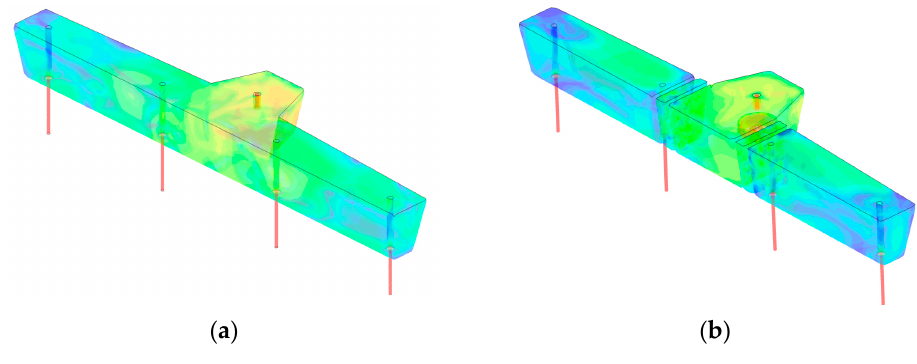
Figure 11. Speed cloud graph display. ( a ) Scheme 0 and ( b ) Scheme 10.